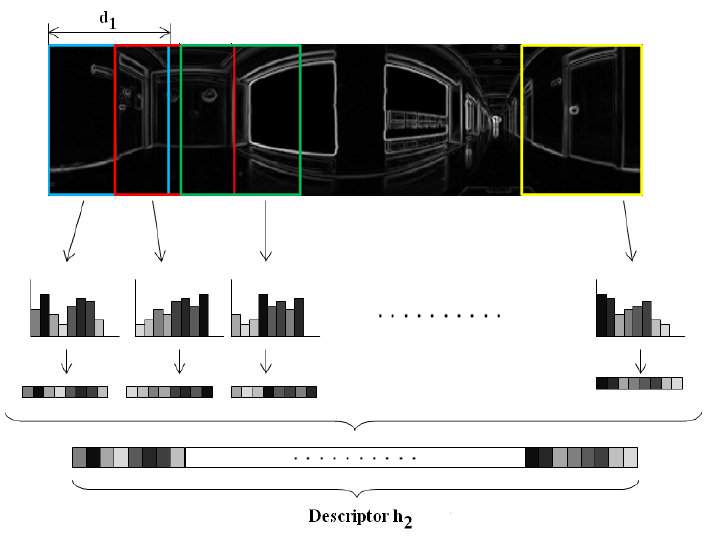
Distribution of overlapping vertical cells on a panoramic image to build a descriptor (cid:126) h that permits estimating the orientation of the 2